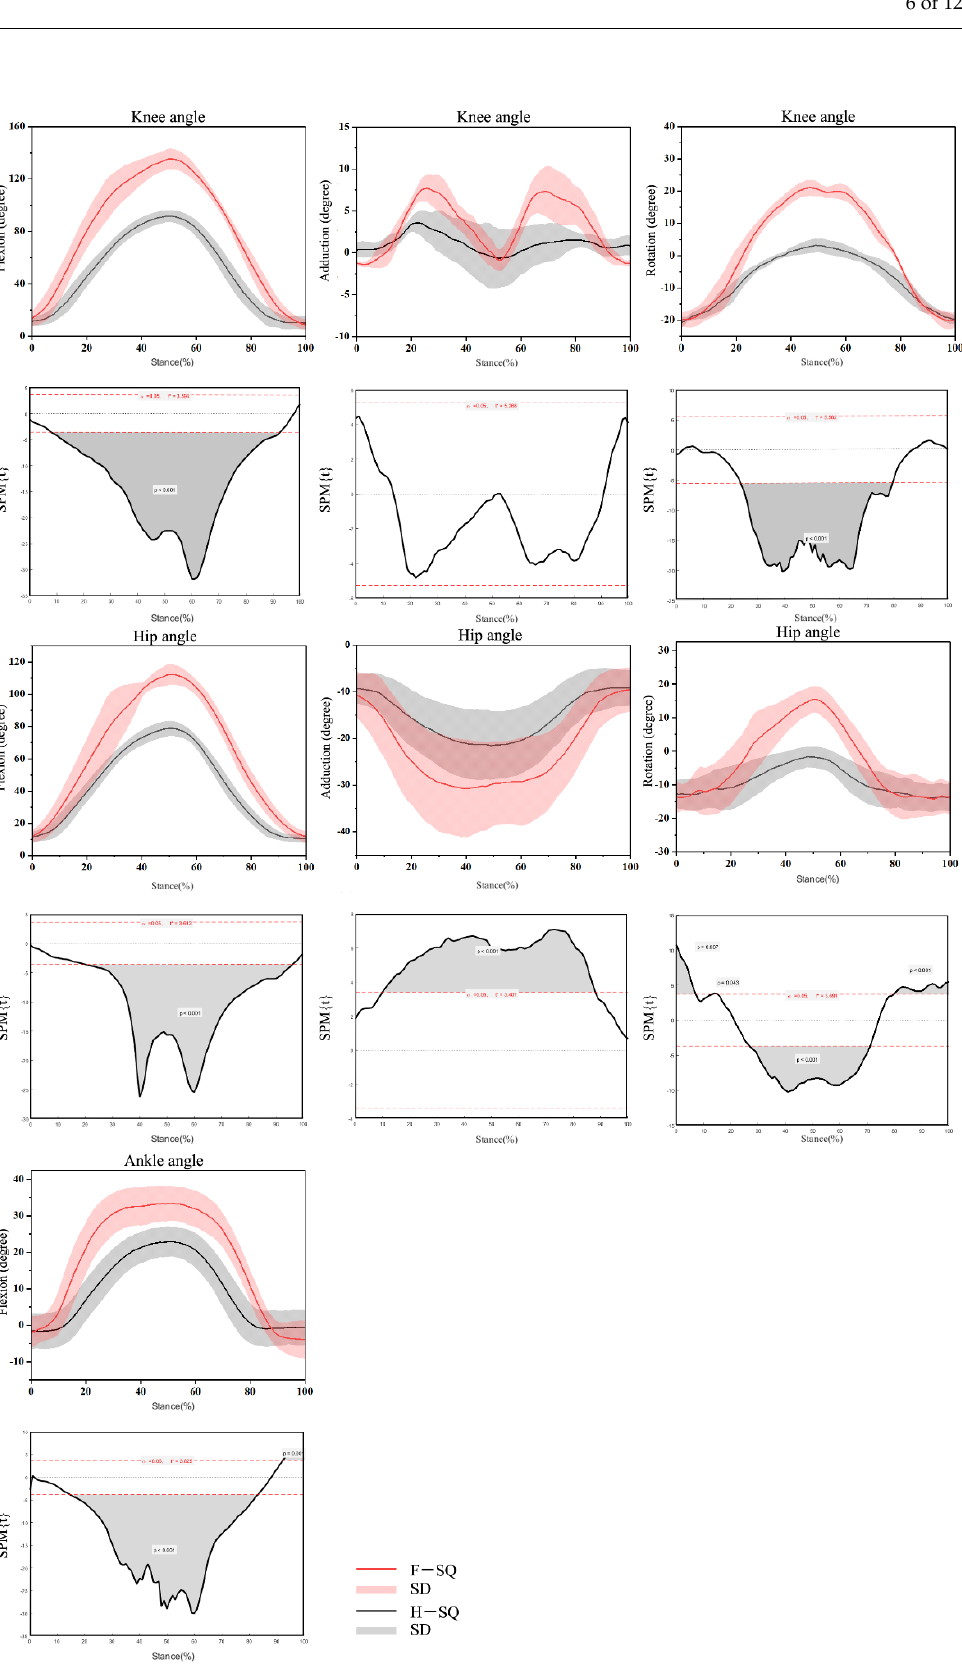
Figure 2. Waveform of angles in the hip, knee and ankle joints during F-SQ and H-SQ with highlighted statistics using SPM1D.